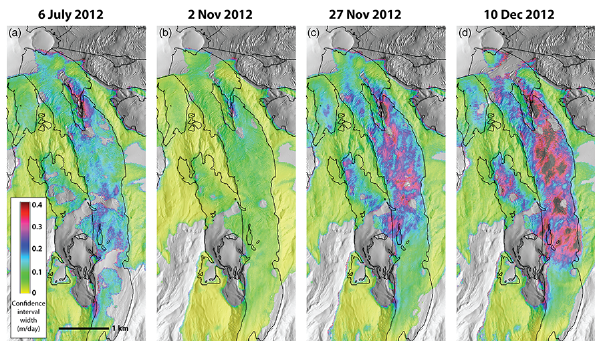
Figure 5. Width of 95% confidence interval (high minus low lim- its for slope-parallel velocity) over Nisqually Glacier computed by bootstrapping. Shown for four sampling periods from the ROI view- point. Note that the color bar is scaled differently than Fig.